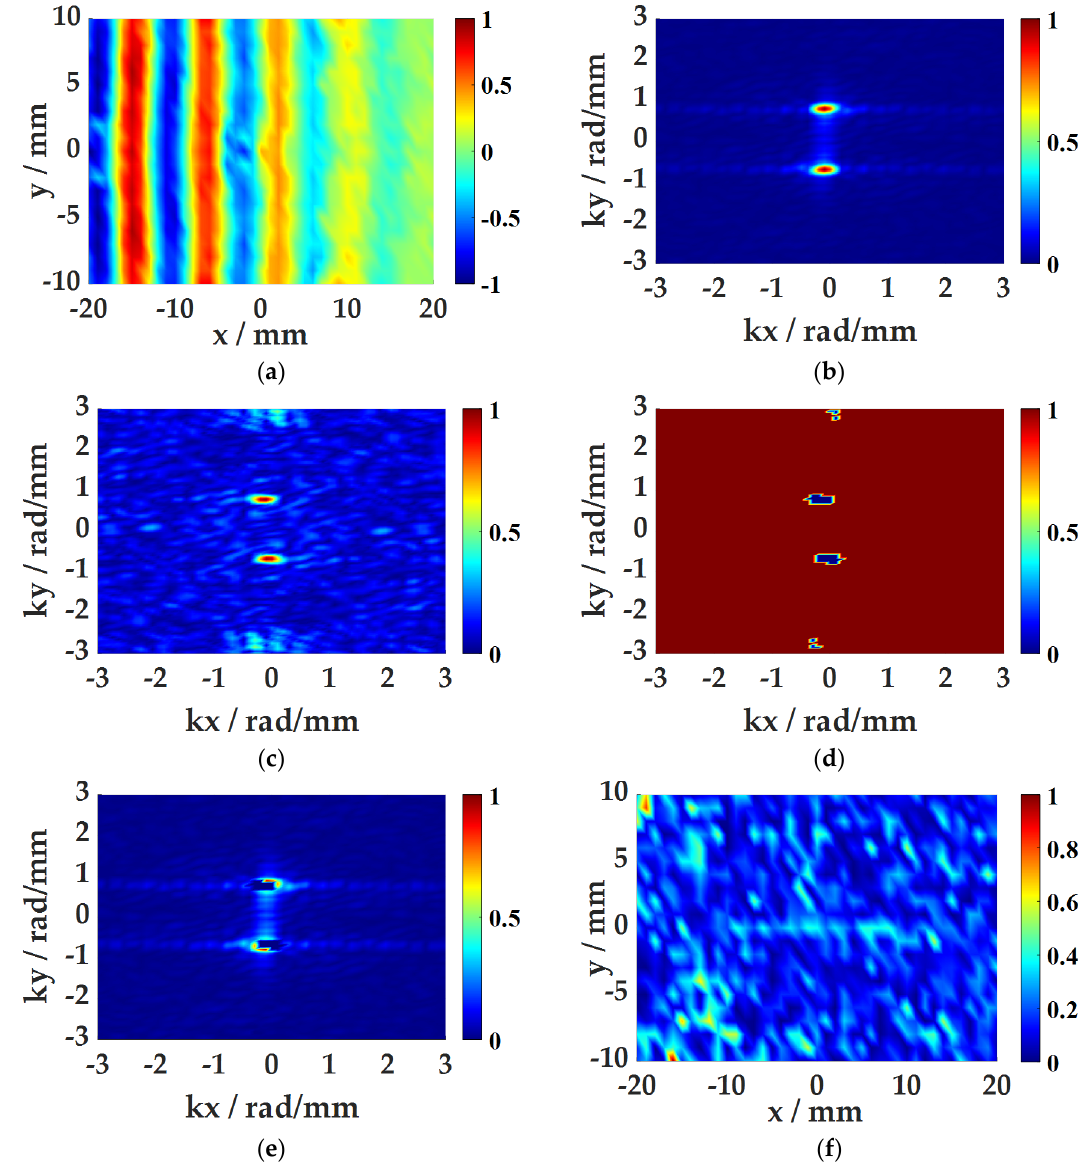
Figure 10. WFA process: ( a ) space-time domain data; ( b ) wavenumber domain spectrum; ( c ) average wavenumber spectrum; ( d ) the threshold filter function; ( e ) wavenumber domain data after filtering ( f ) time–space domain data after filtering.